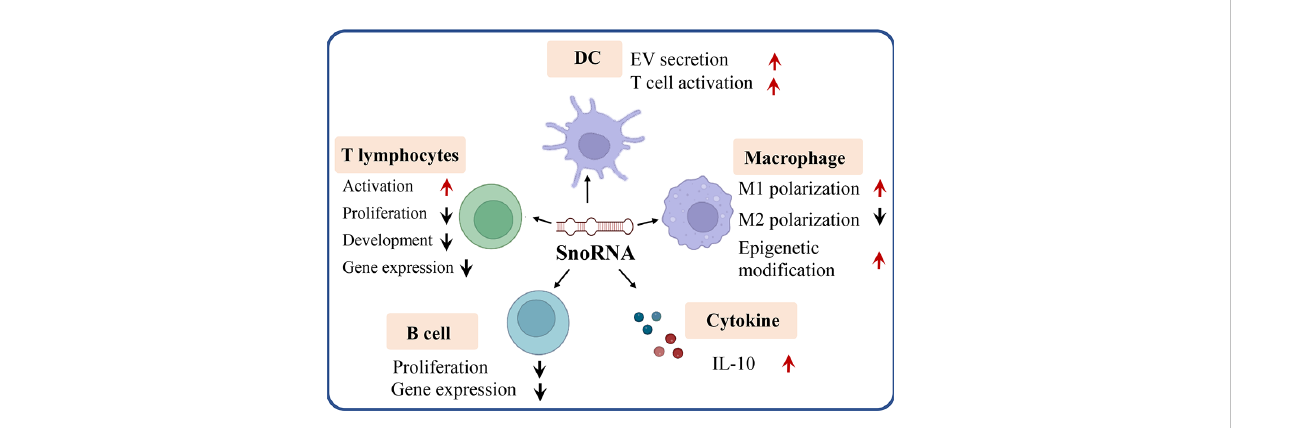
FIGURE 3 SnoRNA regulates varieties of immune cells (e.g. T lymphocytes, B lymphocytes, dendritic cell, macrophage) as well as cytokine like IL-10 to in fl uence tumorigenesis and tumor immunity. Red arrow, upregulation, black arrow, down